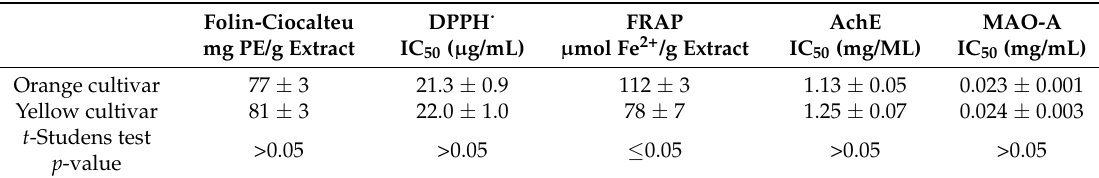
Table 2. Antioxidant and enzyme inhibition activity of flower extracts. The results are presented as mean ±